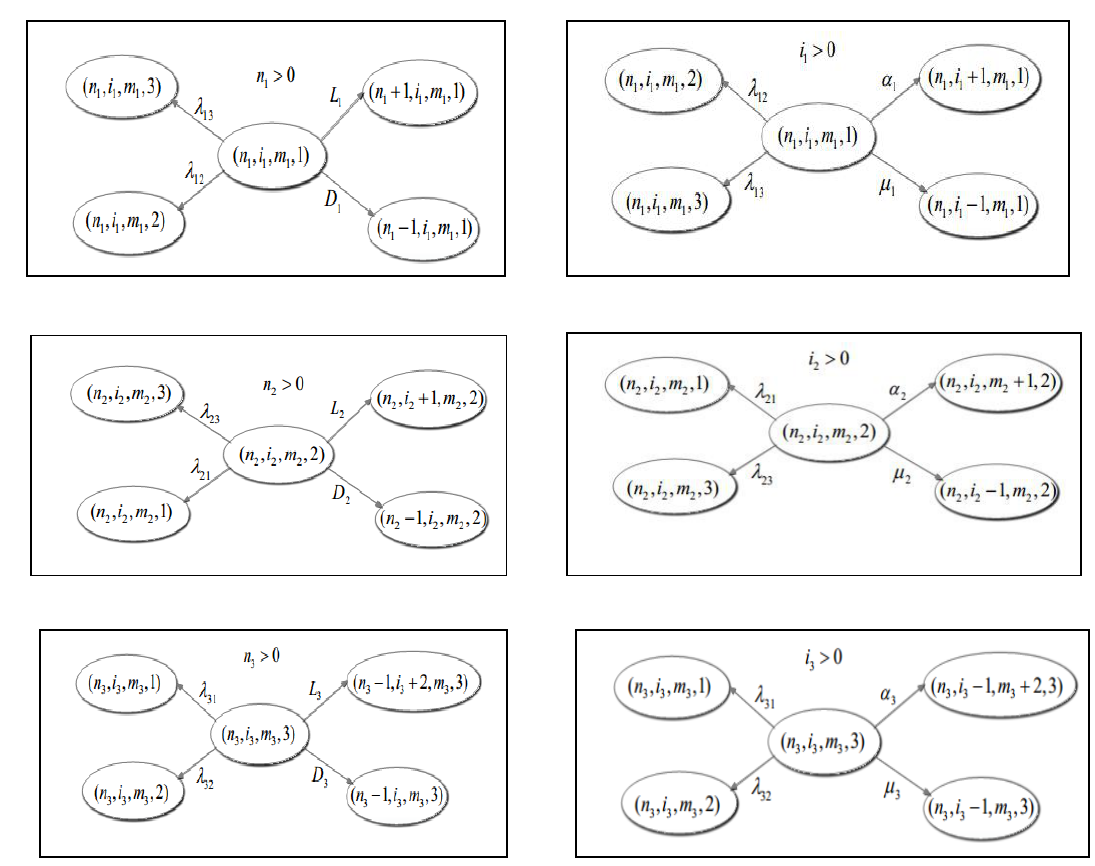
Figure 1. State transition